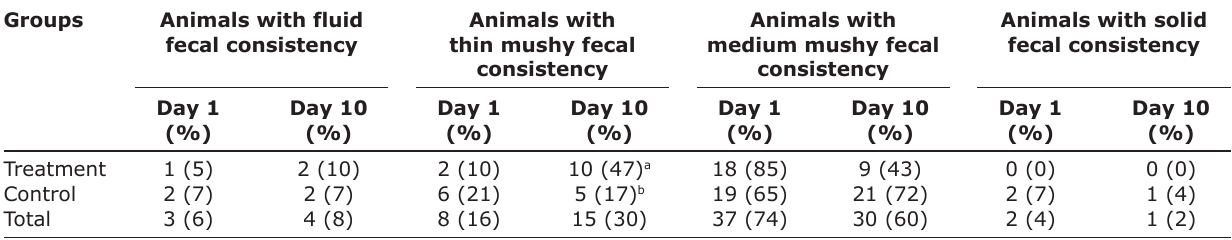
Table-2: Comparison of fecal consistency between the treatment and control groups on days 1 and 10 postpartum. Groups